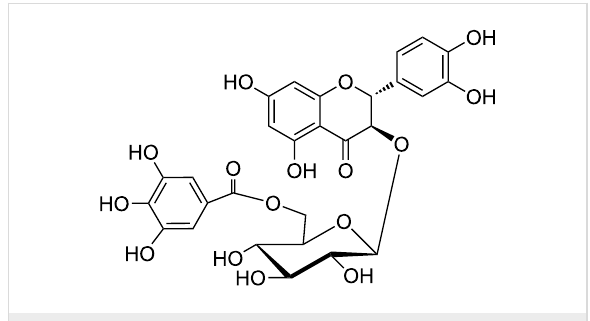
Figure 6: Taxillusin, (2 R ,3 R )-taxifolin 3- β -D-glucopyranoside 6''-gallate ( 24